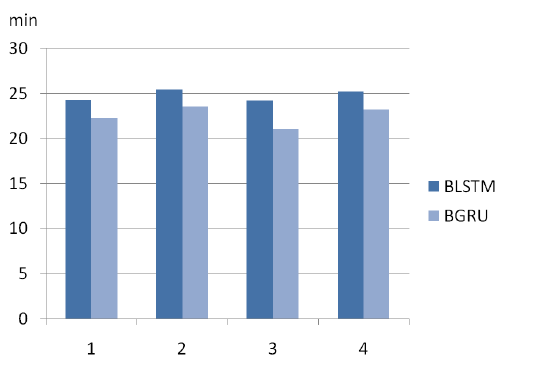
Figure 17. Run-time of four experiments of two models.